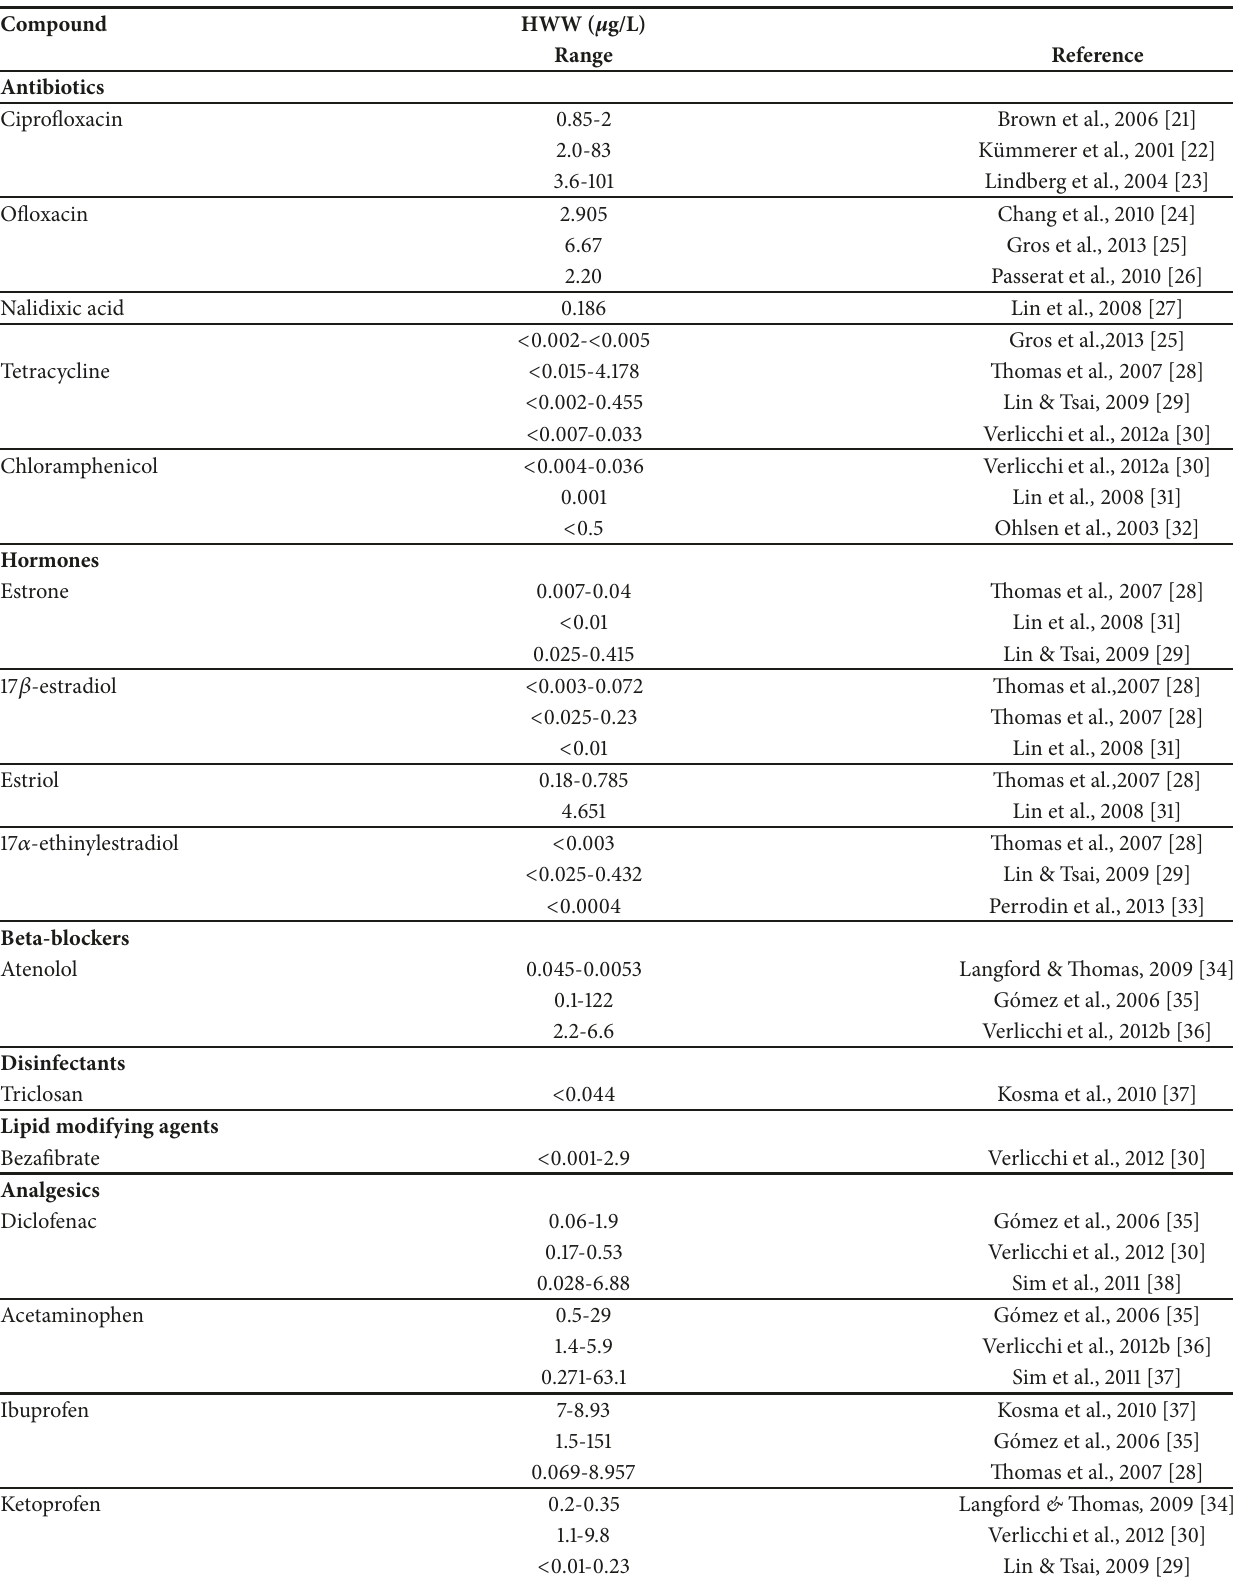
Table 1: Concentrations of different types of pharmaceuticals in HWW from the reviewed